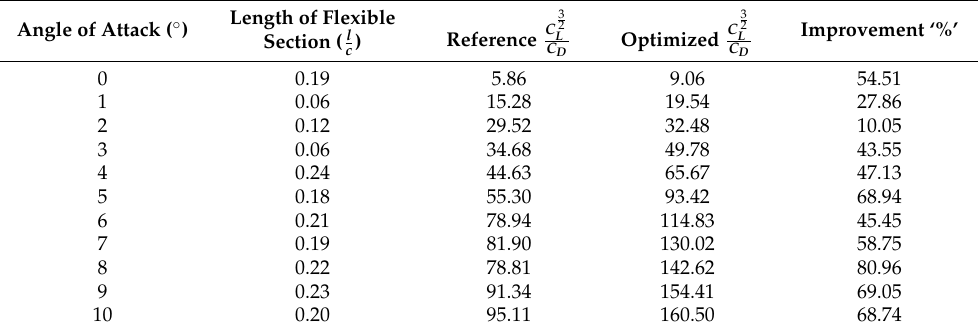
Table 4. Optimized drag results for the reference and optimized morphing airfoils for a certain length of a flexible morphing section for maximization of endurance.